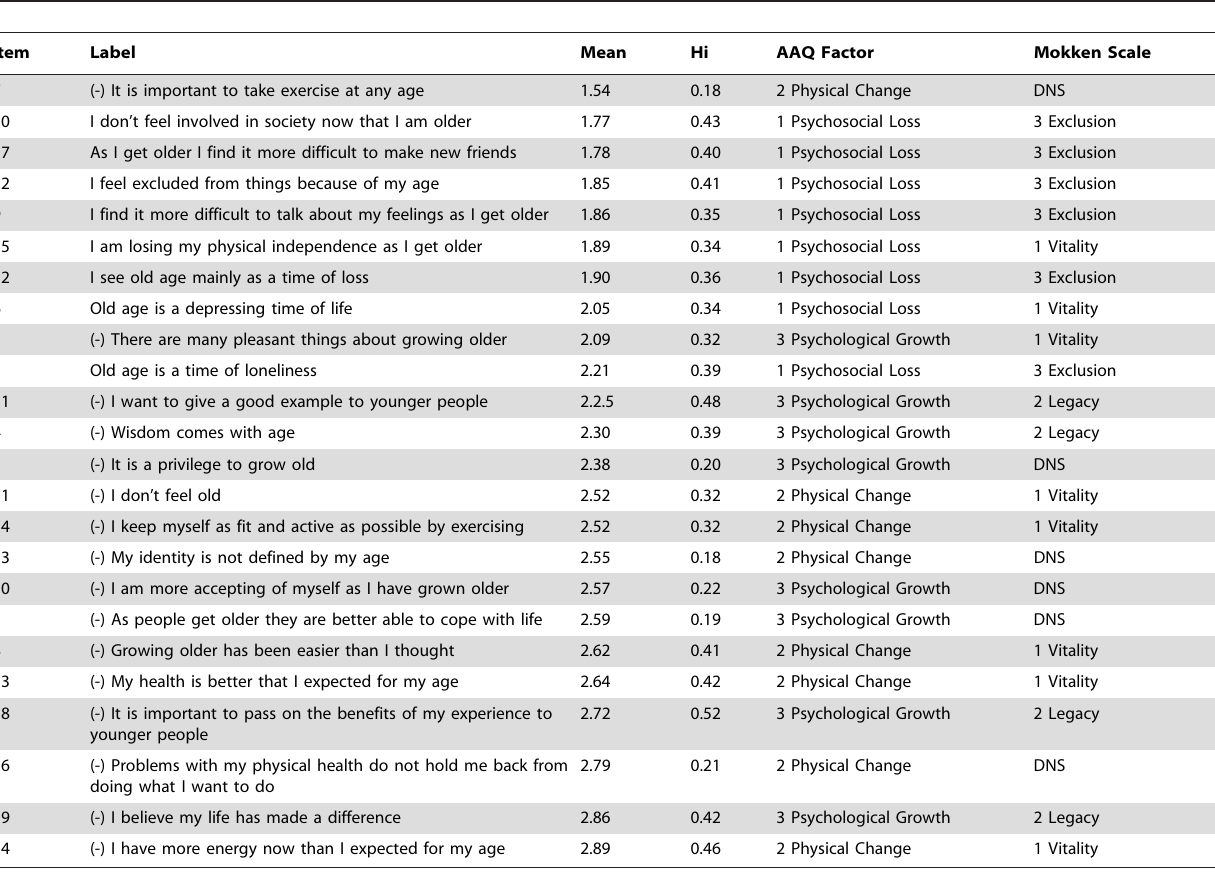
Table 2. Mokken scaling of the Attitudes to Ageing Questionnaire with items ordered according to their mean score (n= 802).